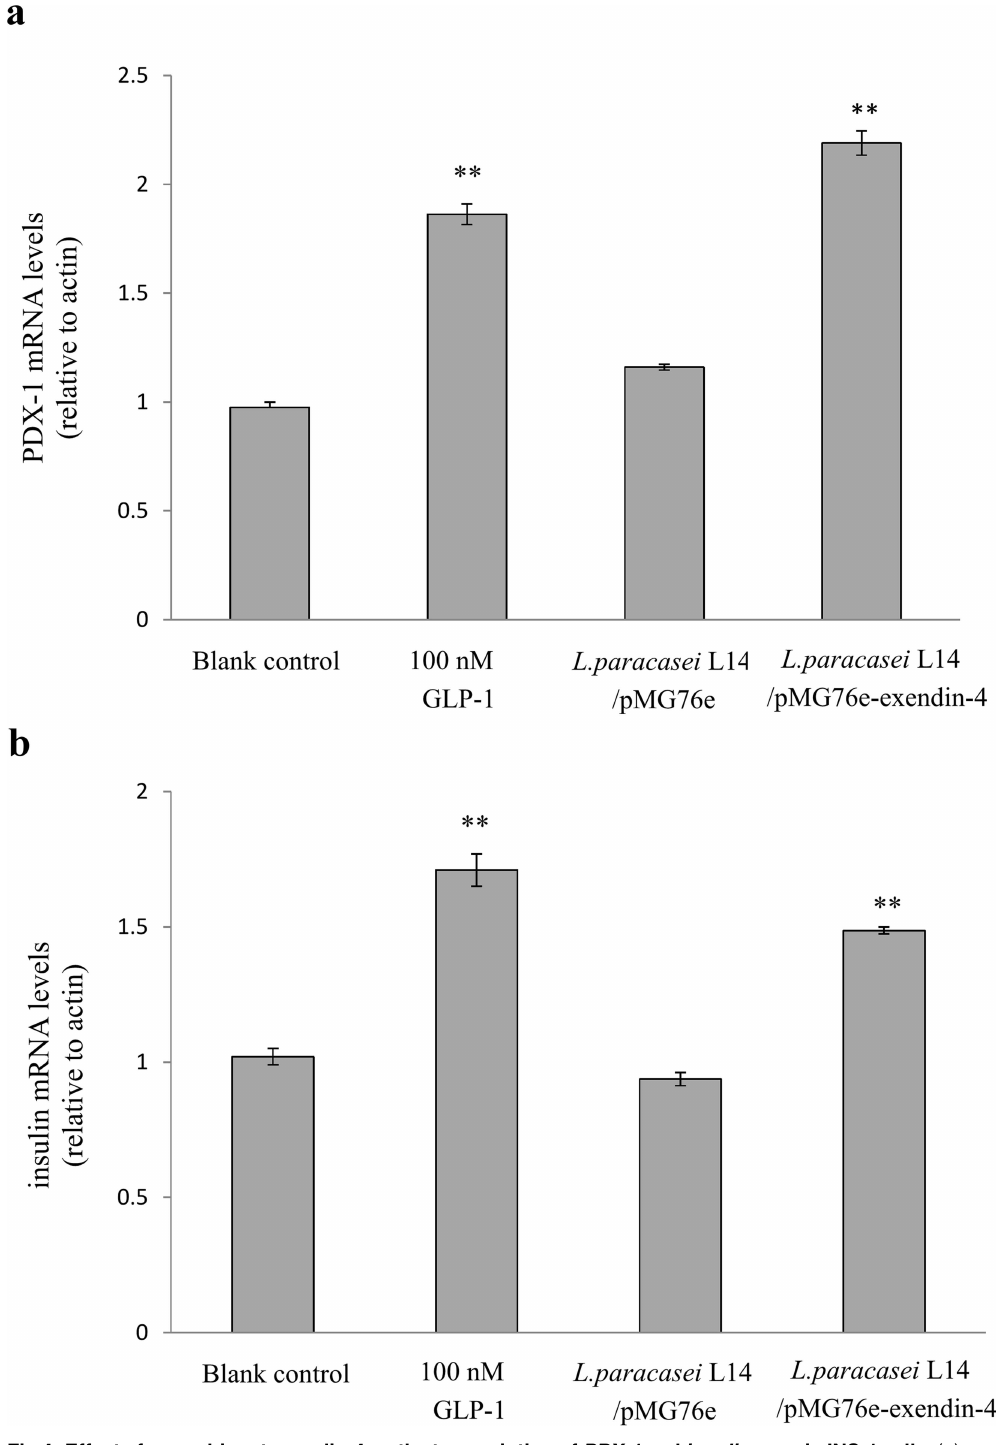
Fig 4. Effect of recombinant exendin-4 on the transcription of PDX-1 and insulin gene in INS-1 cells. (a) PDX -1 mRNA expressionlevel (means ± SD, n = 3). (b) Insulin mRNA expression level (means ± SD, n = 3). ** p < 0.05 vs. control cells with pure cell culture media and L . paracasei